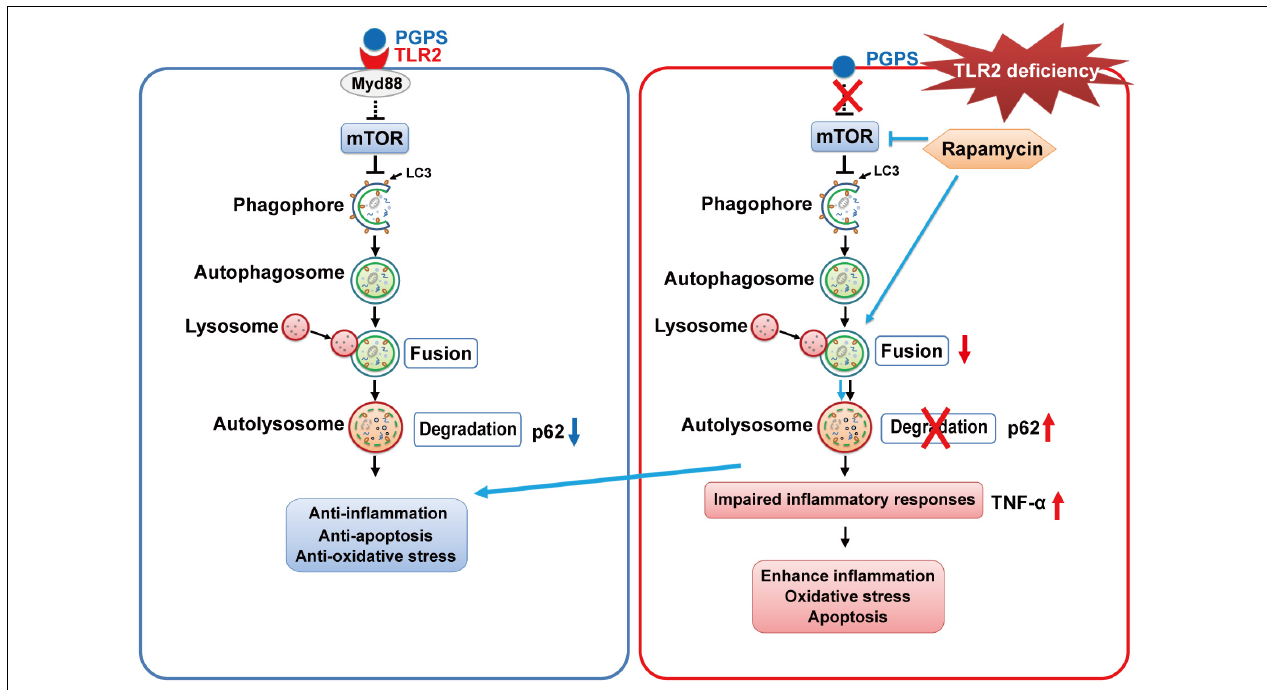
FIGURE 10 | The proposed mechanism for RPM-enhanced autophagy protects against PGPS-induced OM in TLR2 - / - mice. TLR2 deficiency may inhibit fusion between autophagosomes and lysosomes, leading to the accumulation of p62. It may also induce inflammation and apoptosis. RPM treatment may improve the autophagic clearance ability and have a protective effect against OM